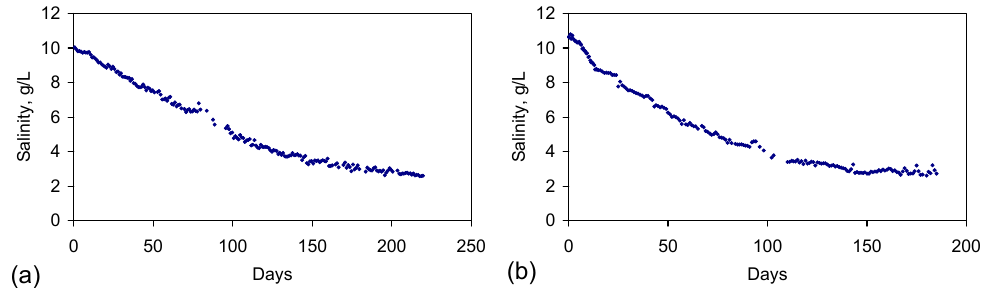
Figure B3. Desalination associated with ZVI catalyst pellet desalination. Type A catalyst (ST). ( a ) ST Trial ST3a [16]; ( b ) ST Trial PE3. Trial Details: (i)